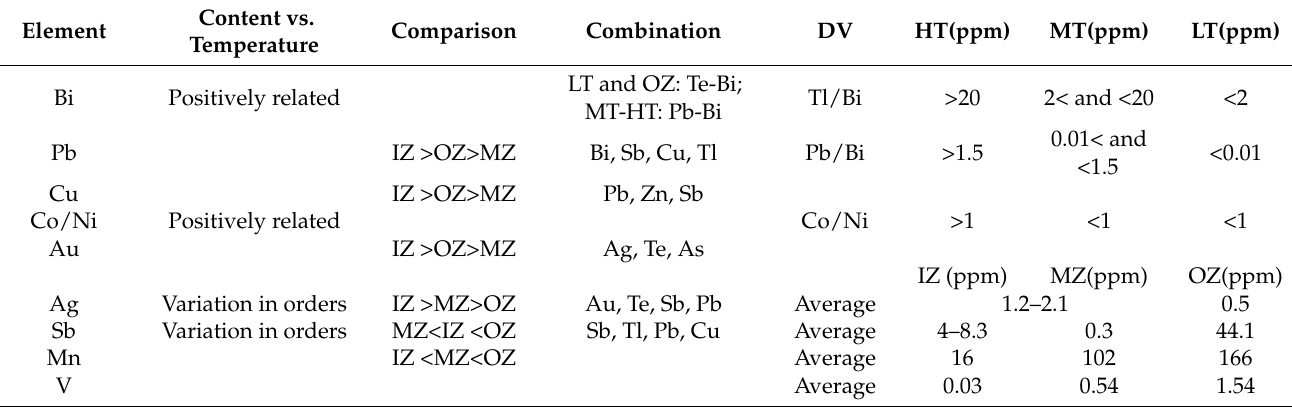
Table 7. Distribution characteristics of trace element in